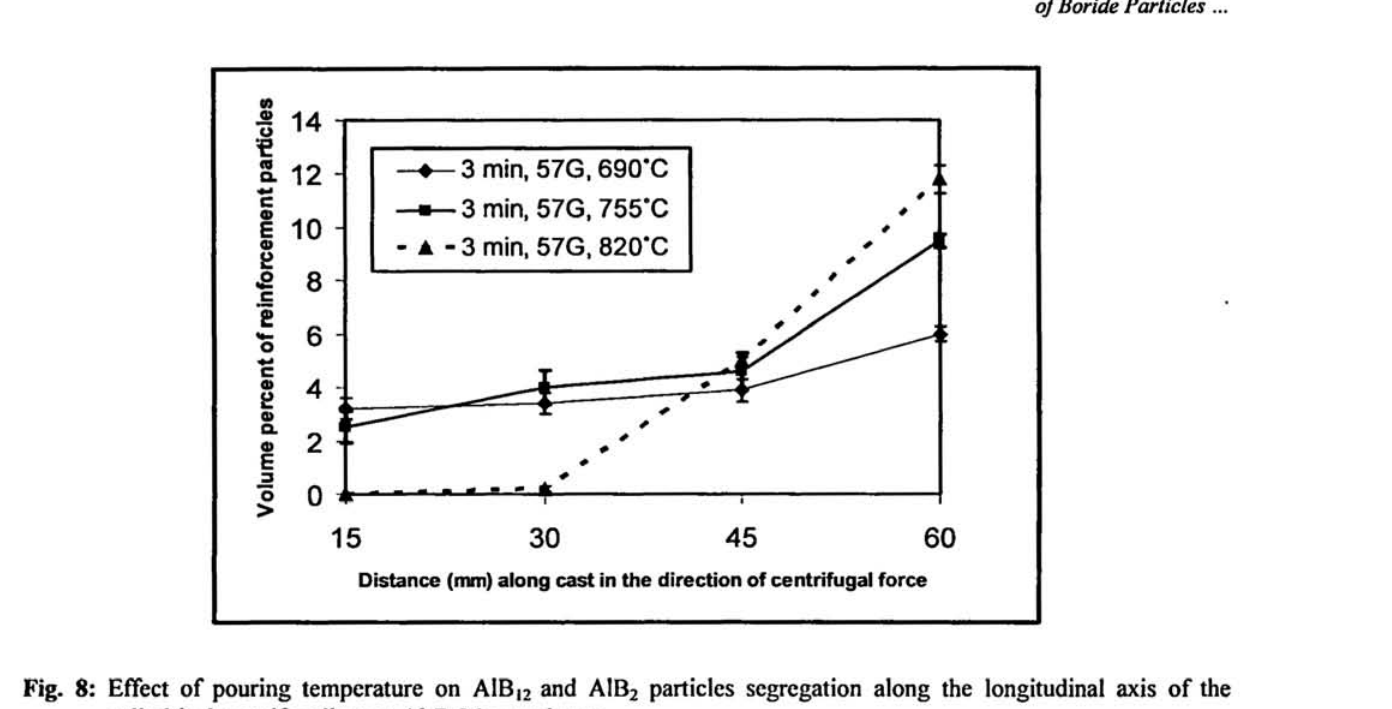
Fig. 8: Effect of pouring temperature on AIB| cylindrical centrifugally cast Al-B-Mg specimens.